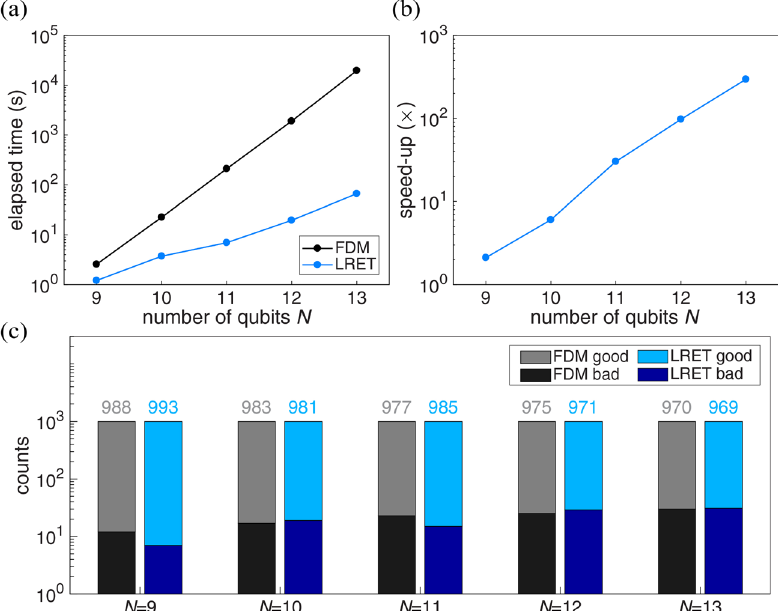
Fig. 10 Results of Grover ’ s search algorithm under depolarizing noise. a Elapsed time on a quantum circuit using FDM (black) and LRET (light blue) in log scale. b Speedup, de fi ned by the ratio of elapsed time between FDM and LRET, in log scale. c Counts of good and bad solutions. The sampling number is 1000. The number on top of each bar marks the counts of good solution found by Grover ’ s Search algorithm for the corresponding method and number of qubits N . The distortion of LRET density matrices are <3.8% in these benchmarking. Parameters are p = 0.1% and ϵ = 10 − 4